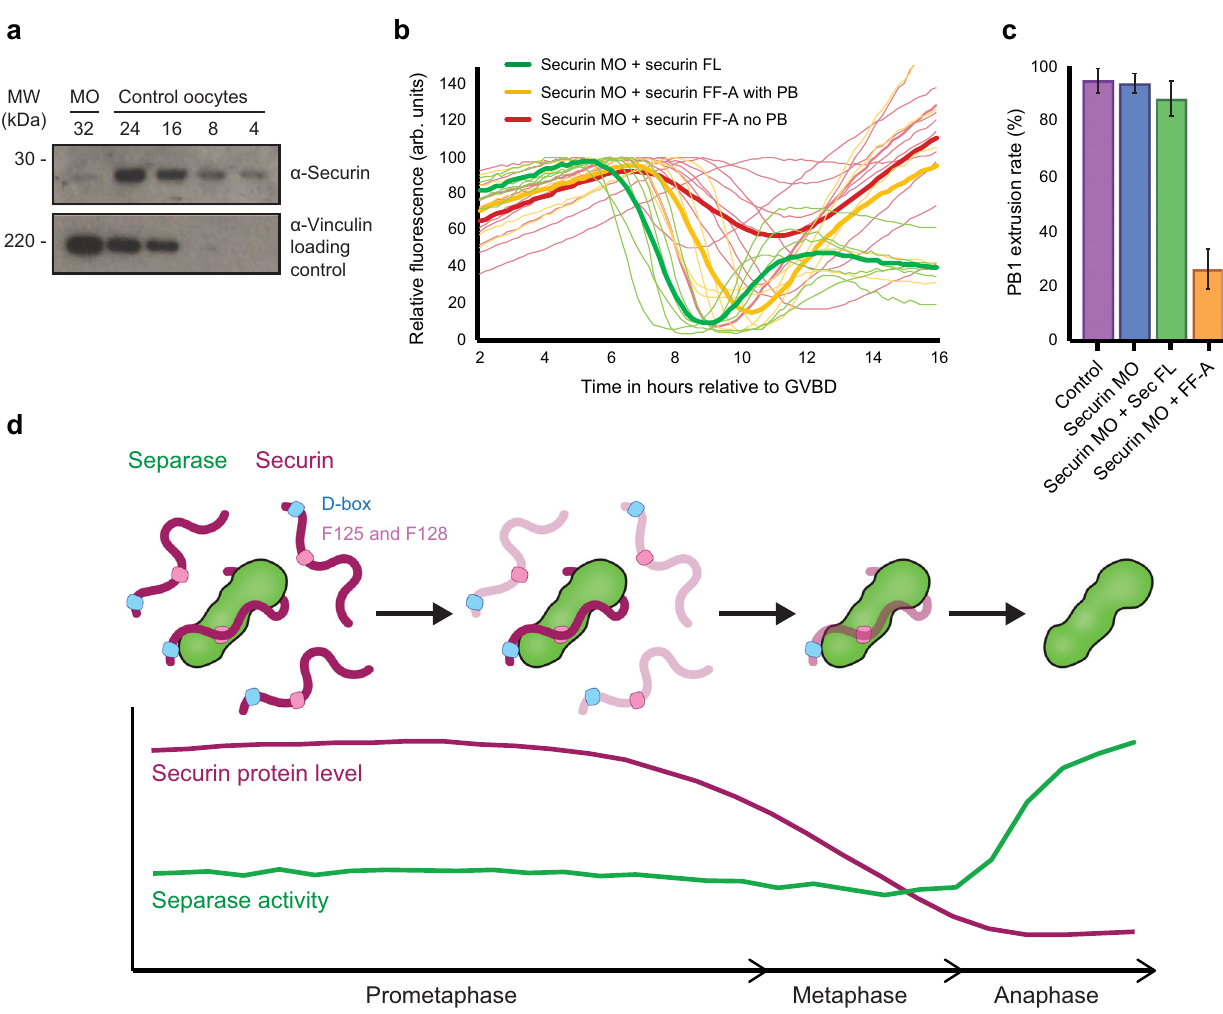
Fig. 4 F125 and F128 are essential for the ef fi cient removal of securin in oocyte meiosis I — where this mechanism is perturbed, oocytes fail to divide. a Quanti fi cation of securin morpholino knockdown. Western blot of control and securin morpholino (MO) injected oocytes collected 5.5 hours post GVBD (numbers of oocytes loaded per lane are indicated). Quanti fi cation of protein bands indicates an 87% knockdown of securin in MO-injected oocytes. The lower blot was probed for vinculin and used as a loading control. b Securin protein levels were knocked down by morpholino (MO) injection. Oocytes were subsequently injected with either securin FL (green traces, n = 6) or securin FF-A (yellow and red traces, n = 15). Although securin FL-injected oocytes had normal rates and timings of PB1 extrusion, FF-A-injected oocytes were either delayed (yellow traces) or blocked in MI (red traces). Destruction pro fi les are relative to GVBD. c Quanti fi cation of PB1 extrusion rate between control oocytes (purple column, n = 50), securin MO-injected oocytes (blue column, n = 29), and securin MO-injected oocytes subsequently injected with either securin FL (green column, n = 15) or securin FF-A (orange column, n = 23). All n numbers refer to the number of individual oocytes analysed over a minimum of three independent experiments. Data presented as mean values with error bars ± SEM. d A model summarising the mechanism by which a pool of excess non-separase-bound securin is preferentially targeted for destruction in late prometaphase I in oocytes. This mechanism involves both the D-box and a second region within the SIS of securin where F125 and F128 are